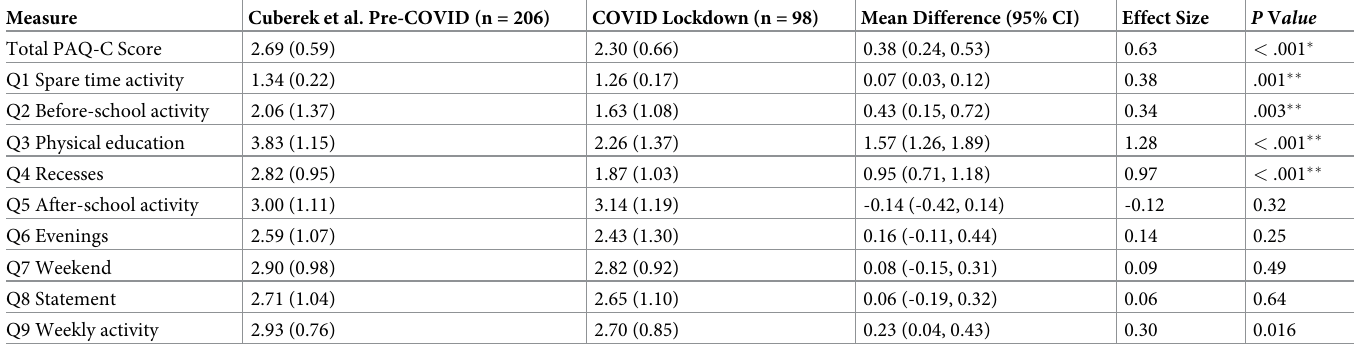
Table 2. Comparison of Czech children scores on the PAQ-C regarding PA before and during COVID pandemic (mean [standard deviation]). Measure Cuberek et al. Pre-COVID (n = 206) COVID Lockdown (n = 98) Mean Difference (95% CI) P V